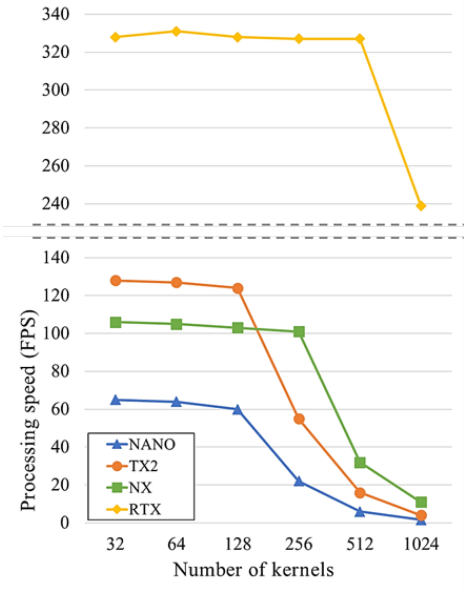
Figure 1. Processing speed comparison by the number of kernels on edge-computing